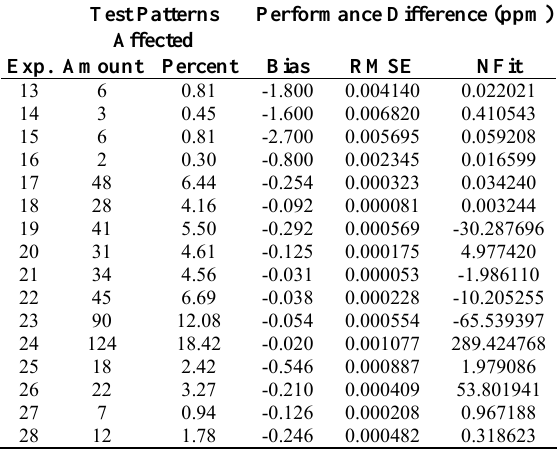
Table 8. Effects of modified method of the 2G; Exp. means “Experiment”.